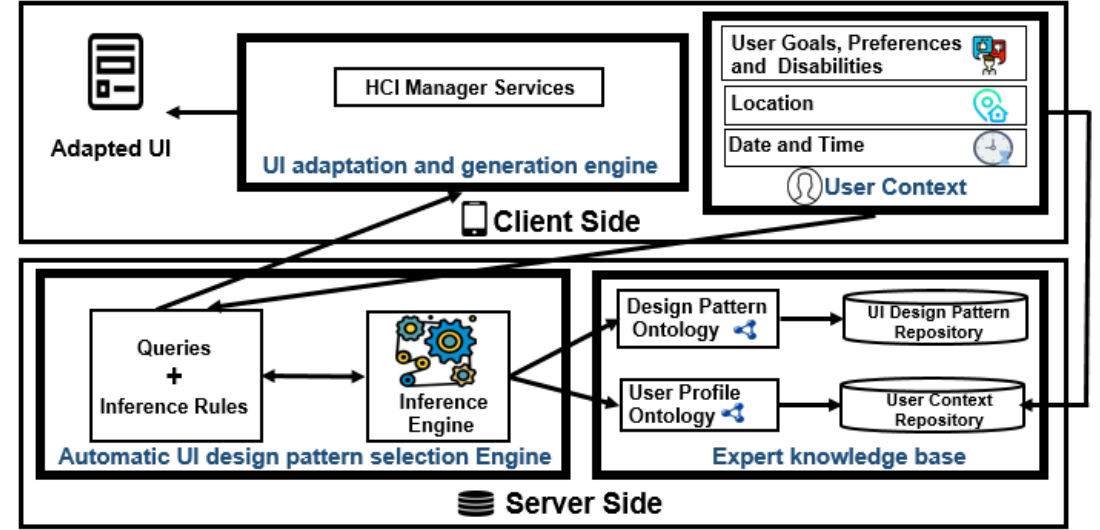
Figure 3. Framework